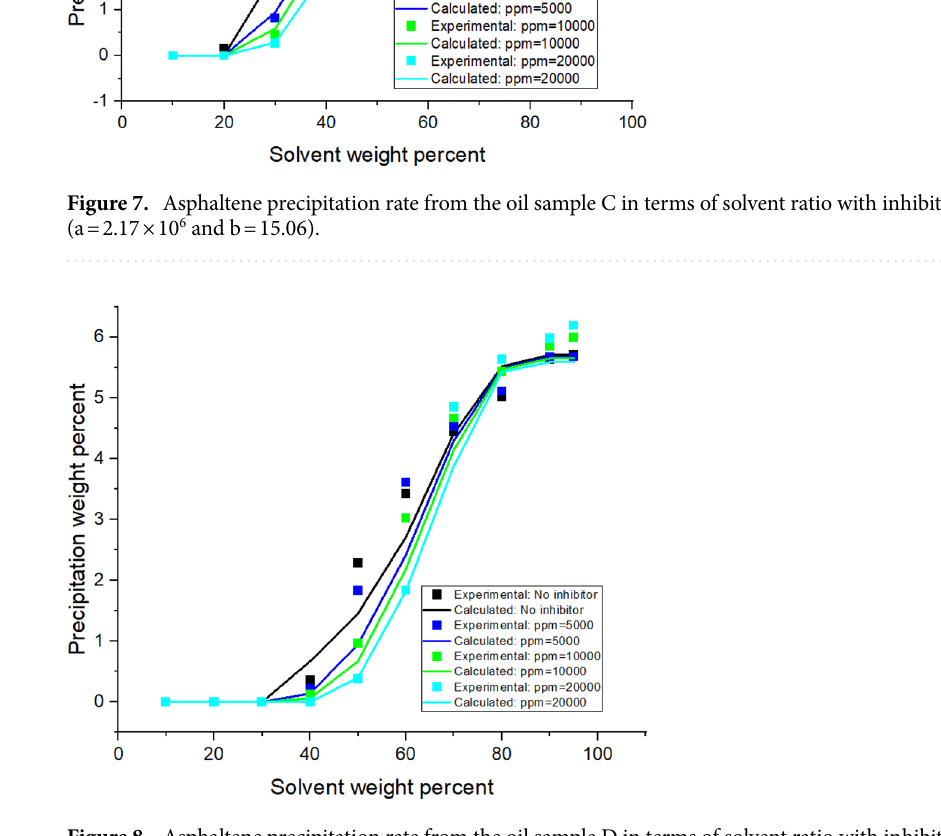
Figure 8. Asphaltene precipitation rate from the oil sample D in terms of solvent ratio with inhibitor (a = 5.28 × 10 7 and b =